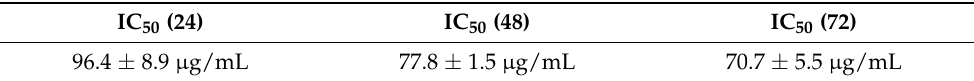
Table 2. IC 50 values (concentration that causes a 50% inhibition in cell growth) of LCO against DA3 cells determined by the SRB assay after a 24-, 48-, or a 72-h treatment. Data are representative of at least three independent experiments and are presented as mean ±